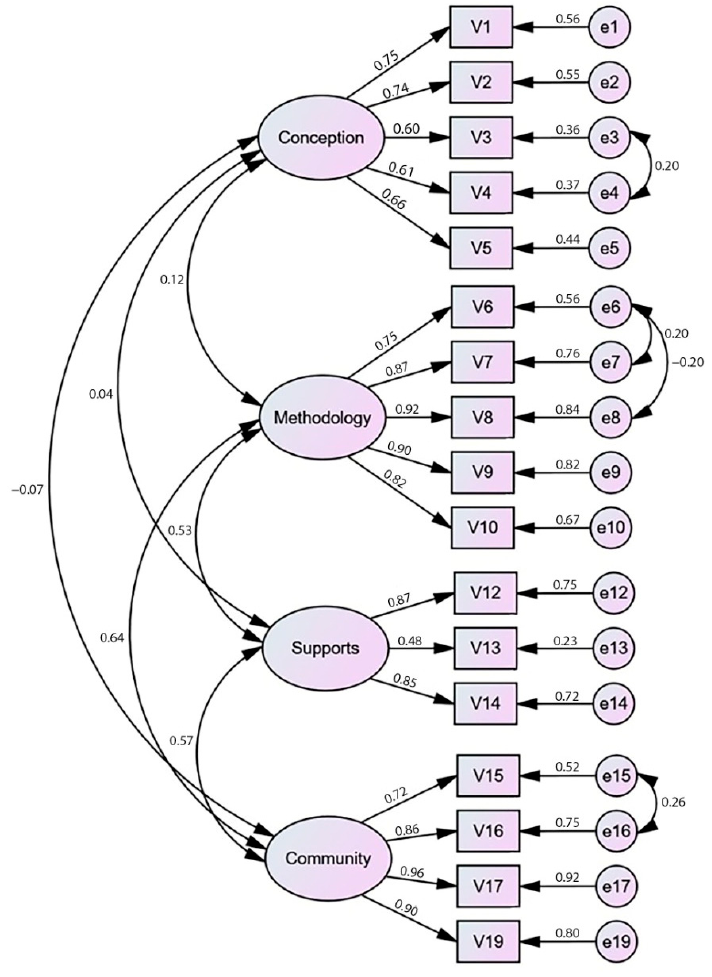
Figure 1. CEFI-R questionnaire factor model. Table 6. CEFI-R questionnaire goodness-of-fit indices.